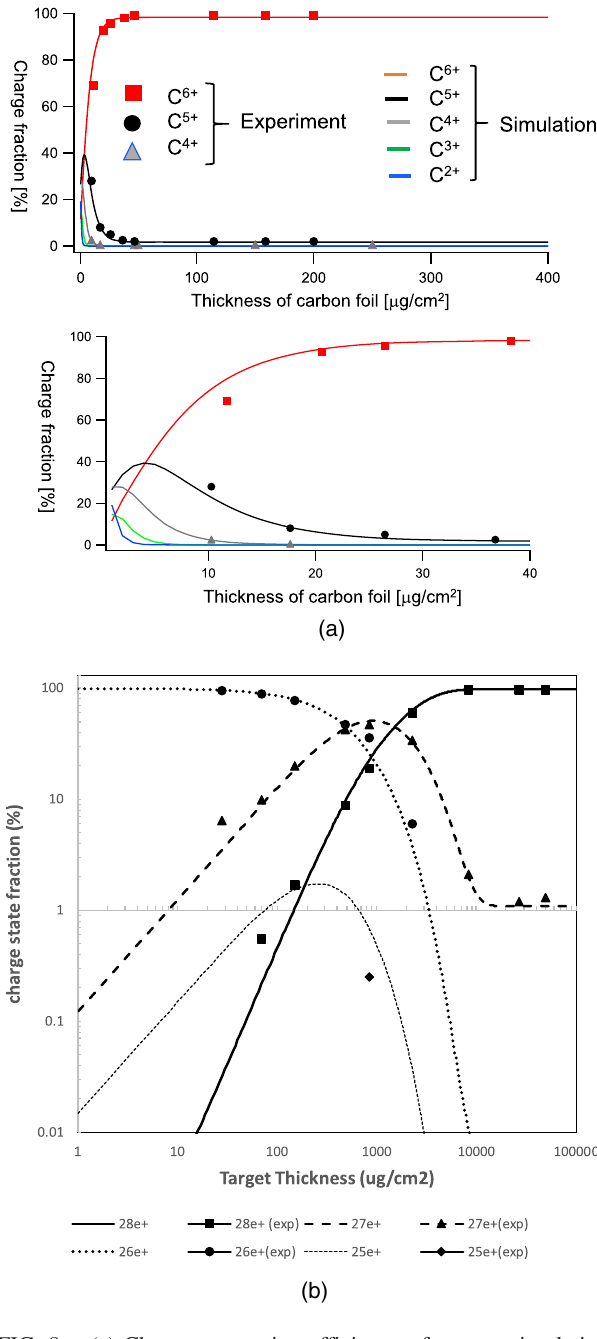
FIG. 8. (a) Charge conversion efficiency of LISE ++ simulation and existing experimental results. The lower panel is an enlarge- ment in the thin foil region. Plotting of the simulation results starts from 1 μ g = cm 2 . (b) The measured charge state distribution vs carbon-foil target thickness and simulation